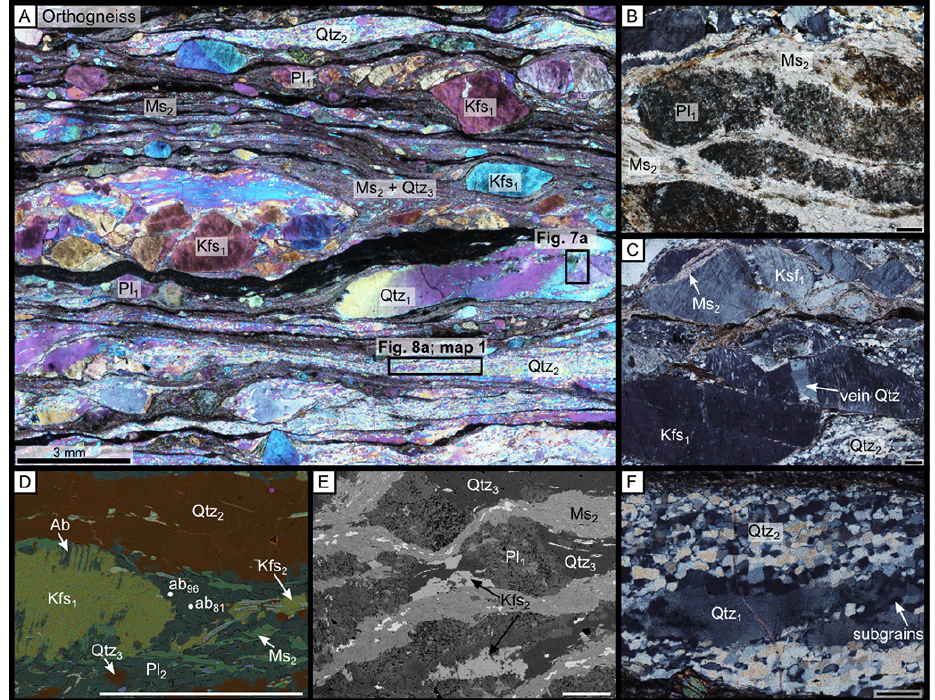
Figure 5. Typical microstructures and mineralogy in orthogneiss; scale bar for (b) – (f) is 200µm. (a) Optical micrograph (crossed polariz- ers with gypsum plate inserted) showing large fractured feldspar grains (Kfs 1 and Pl 1 ) ; undulose extinction in quartz (Qtz 1 ) ; fine-grained, monomineralic domains of Qtz 2 ; and thin, muscovite-rich mantles surrounding Kfs 1 and Pl 1 . (b) Optical micrograph (crossed polarizers) showing fine-grained muscovite (Ms 2 ) corona around plagioclase (Pl 1 ) . (c) Optical micrograph (crossed polarizers) showing book-shelf fractures in K-feldspar (Kfs 1 ) and muscovite (Ms 2 ) aggregates associated with fractures and grain boundaries. (d) EDX- derived composi- tional map showing Kfs 1 grain with albite exsolution lamellae and Pl 2 , Qtz 3 , Kfs 2 and Ms 2 in the strain shadow, where the small plagioclase grains have variable compositions typically having oligoclase cores and albite rims. (e) BSE image showing Pl 1 porphyroclasts with Qtz 3 and Kfs 2 in the strain shadows and Ms 2 forming strain caps. (b) Optical micrograph (crossed polarizers) showing Qtz 1 grain surrounded by Qtz 2 aggregates. Qtz 1 displays undulose extinction and subgrains exhibiting similar sizes to Qtz 2